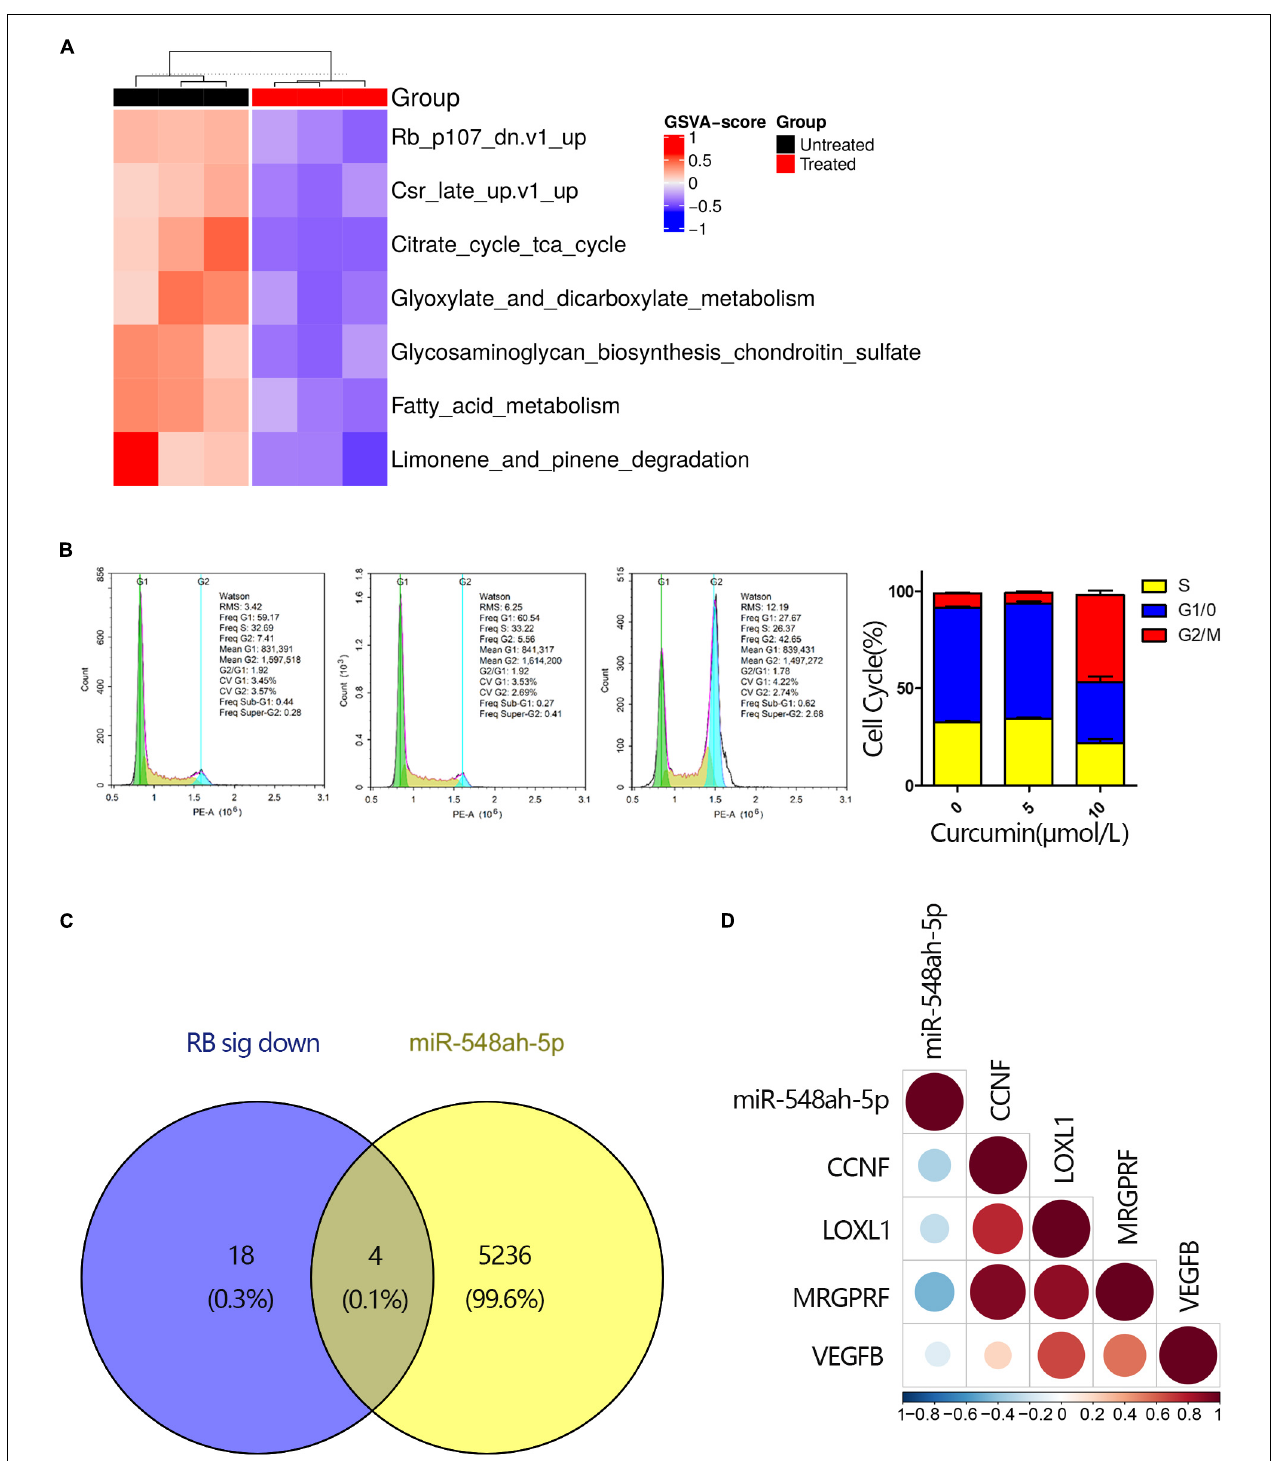
FIGURE 4 | The disturbation of cell cycle-related pathways contributed to the cell apoptosis. (A) GSVA score for differential KEGG gene sets between curcumin-untreated and treated groups ( n = 3). Each column represented a tested sample while each row represented a KEGG pathway. GSVA scores reflected the variation in activeness of different pathways. Hierarchical clustering heatmap indicated differential oncogenic gene sets and the brightness of the color was related to GSVA scores. (B) Cell cycle analysis for H446 cells was measured by flow cytometry after cultured with curcumin (0, 5, 10 µ M) for 24 h and ratio of different phases were shown ( n = 3). (C) Venn diagram of all down-regulated DEGs in the RB signature and genes targeted by miRNA-548ah-5p. (D) The relevance between miRNA-548ah-5p expression and its potential target genes in RB signature. Colors and sizes of the spots represent the relevance scores.